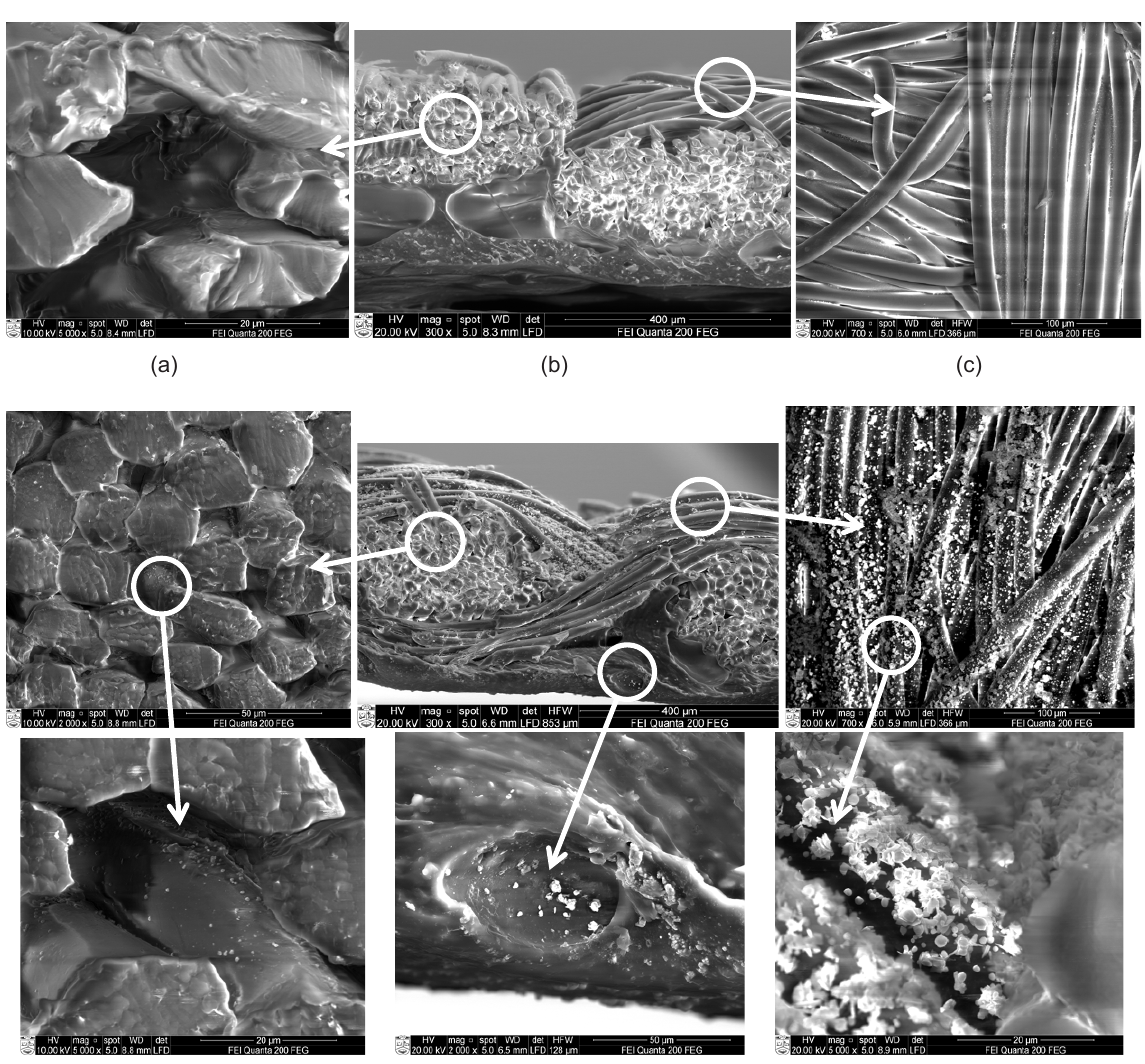
Figure 2. SEM image of investigated silicone coated polyamide cloth before (a, b, c) and after (d) the treatment of silver selenide; a – crossection of multifilament yarn, b – cross-section of silicone coated polyamide plane weave fabric, c – fabric surface without silicone